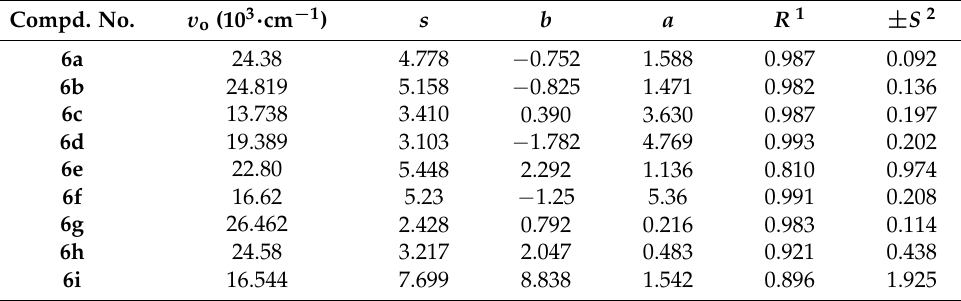
Table 5. Regression fits to solvatochromic parameters (Equation (1)).